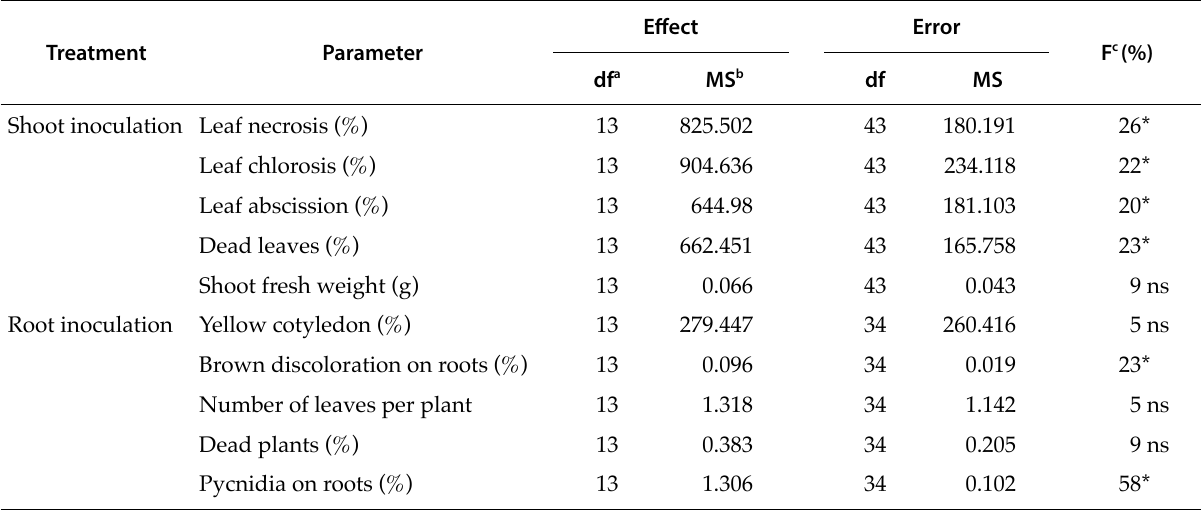
Table 2. Analysis of variance of measured parameters on Medicago truncatula shoots and roots 15 days post inoculation with 14 Phoma medicaginis